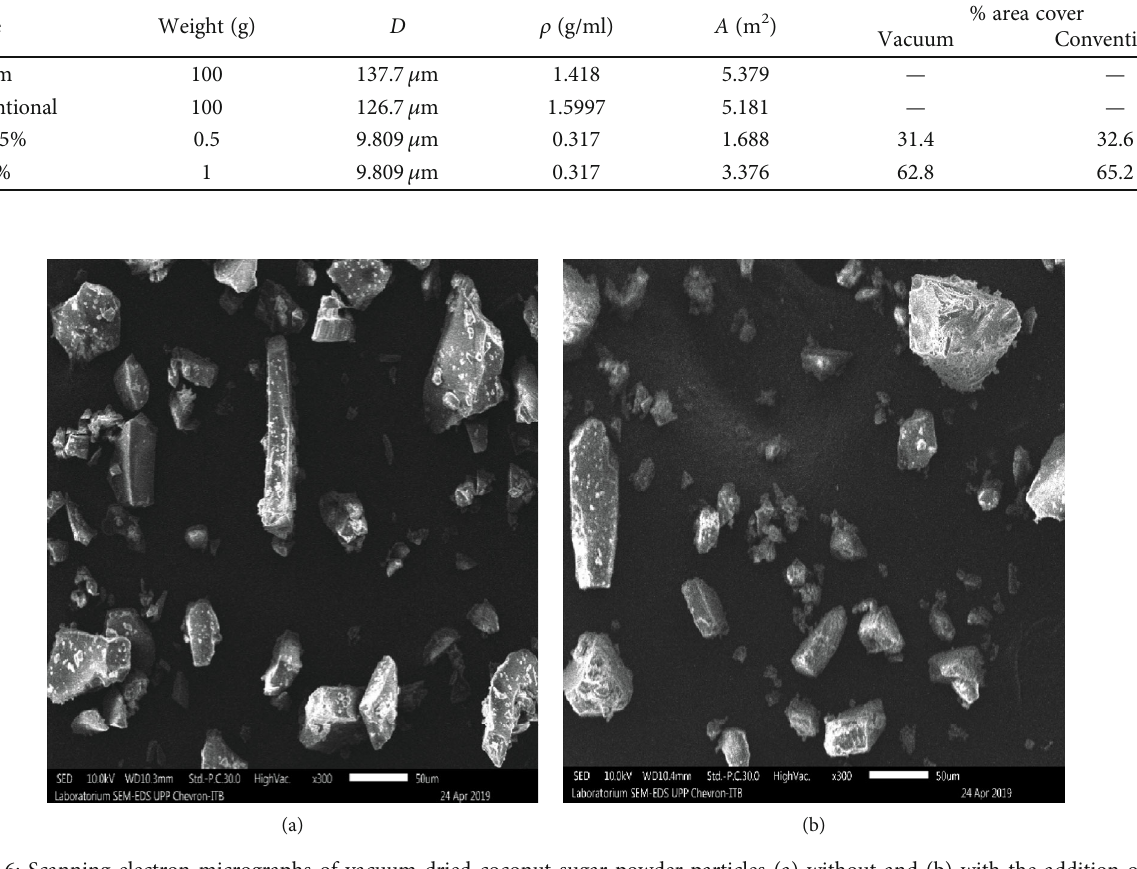
Figure 6: Scanning electron micrographs of vacuum-dried coconut sugar powder particles (a) without and (b) with the addition of 1% tricalcium